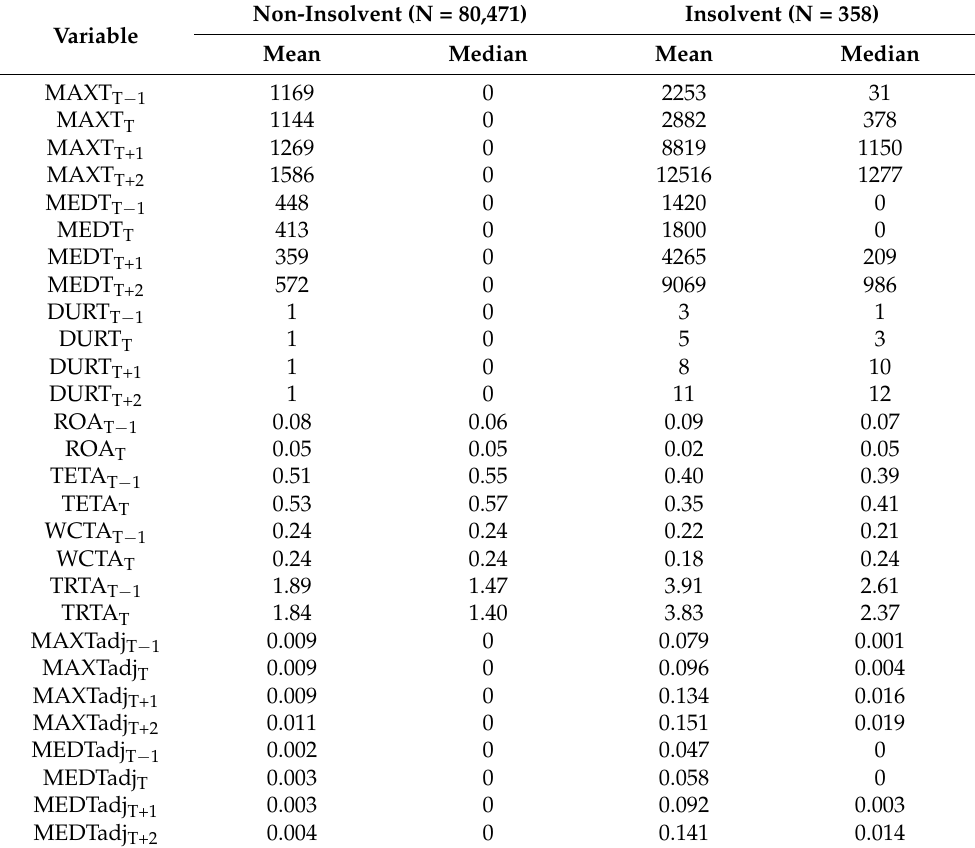
Table 3. Descriptive statistics of variables